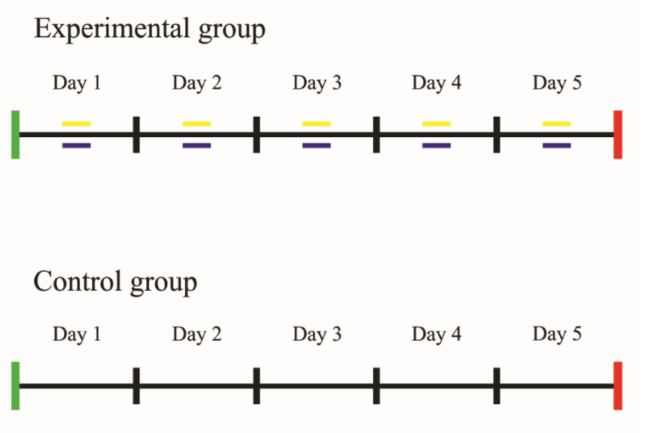
Figure 2. The flow of study interventions. Green (Day 1): eligibility criteria, informed consent, and baseline balance assessments (mCTSIB, Tandem Walk Test). Red (Day 5): end of intervention, follow-up balance assessment (mCTSIB, Tandem Walk Test). Yellow (Day 1–Day 5): slackline training sessions. Blue (Day 1–Day 5): SenseWear Armband